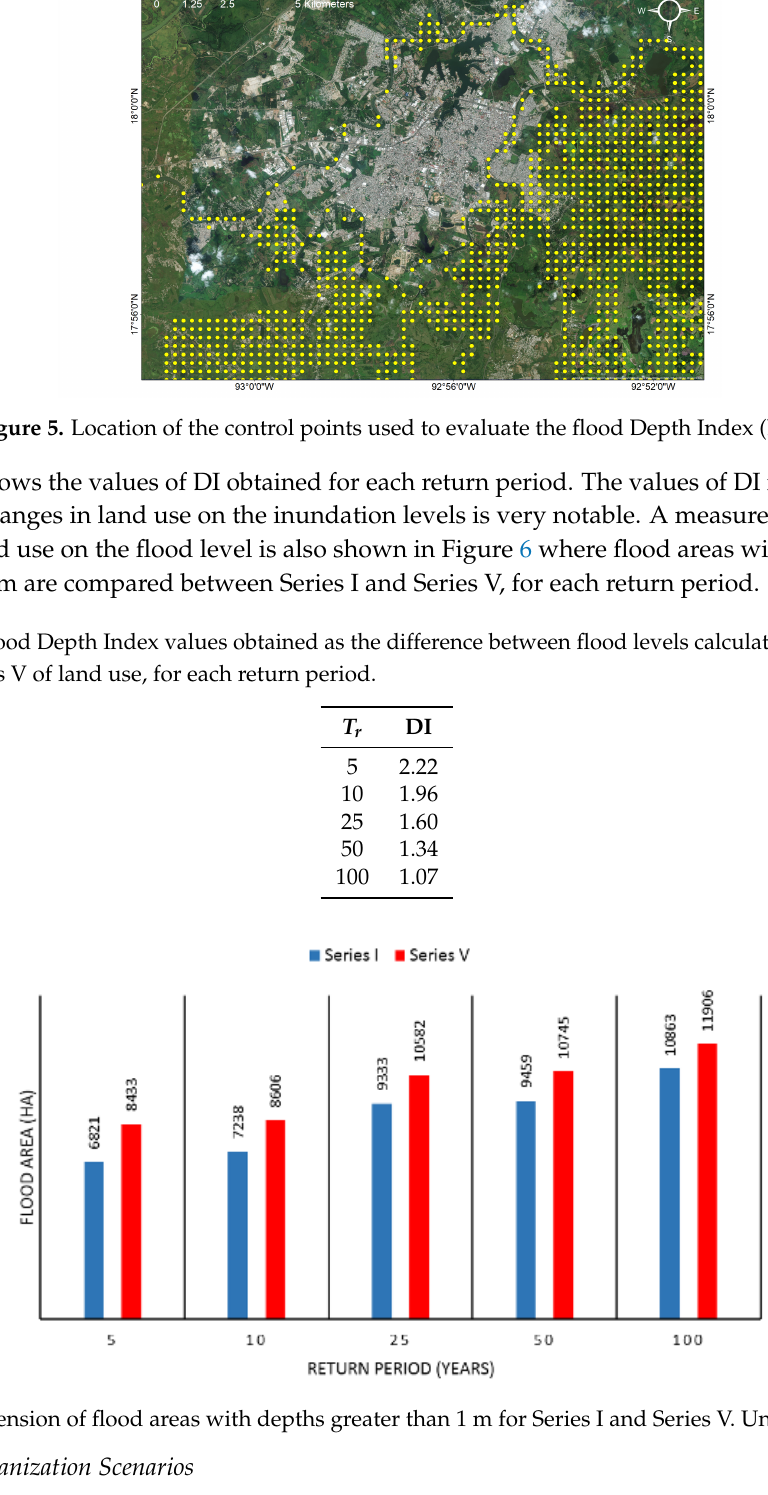
Figure 6. Extension of flood areas with depths greater than 1 m for Series I and Series V. Units in